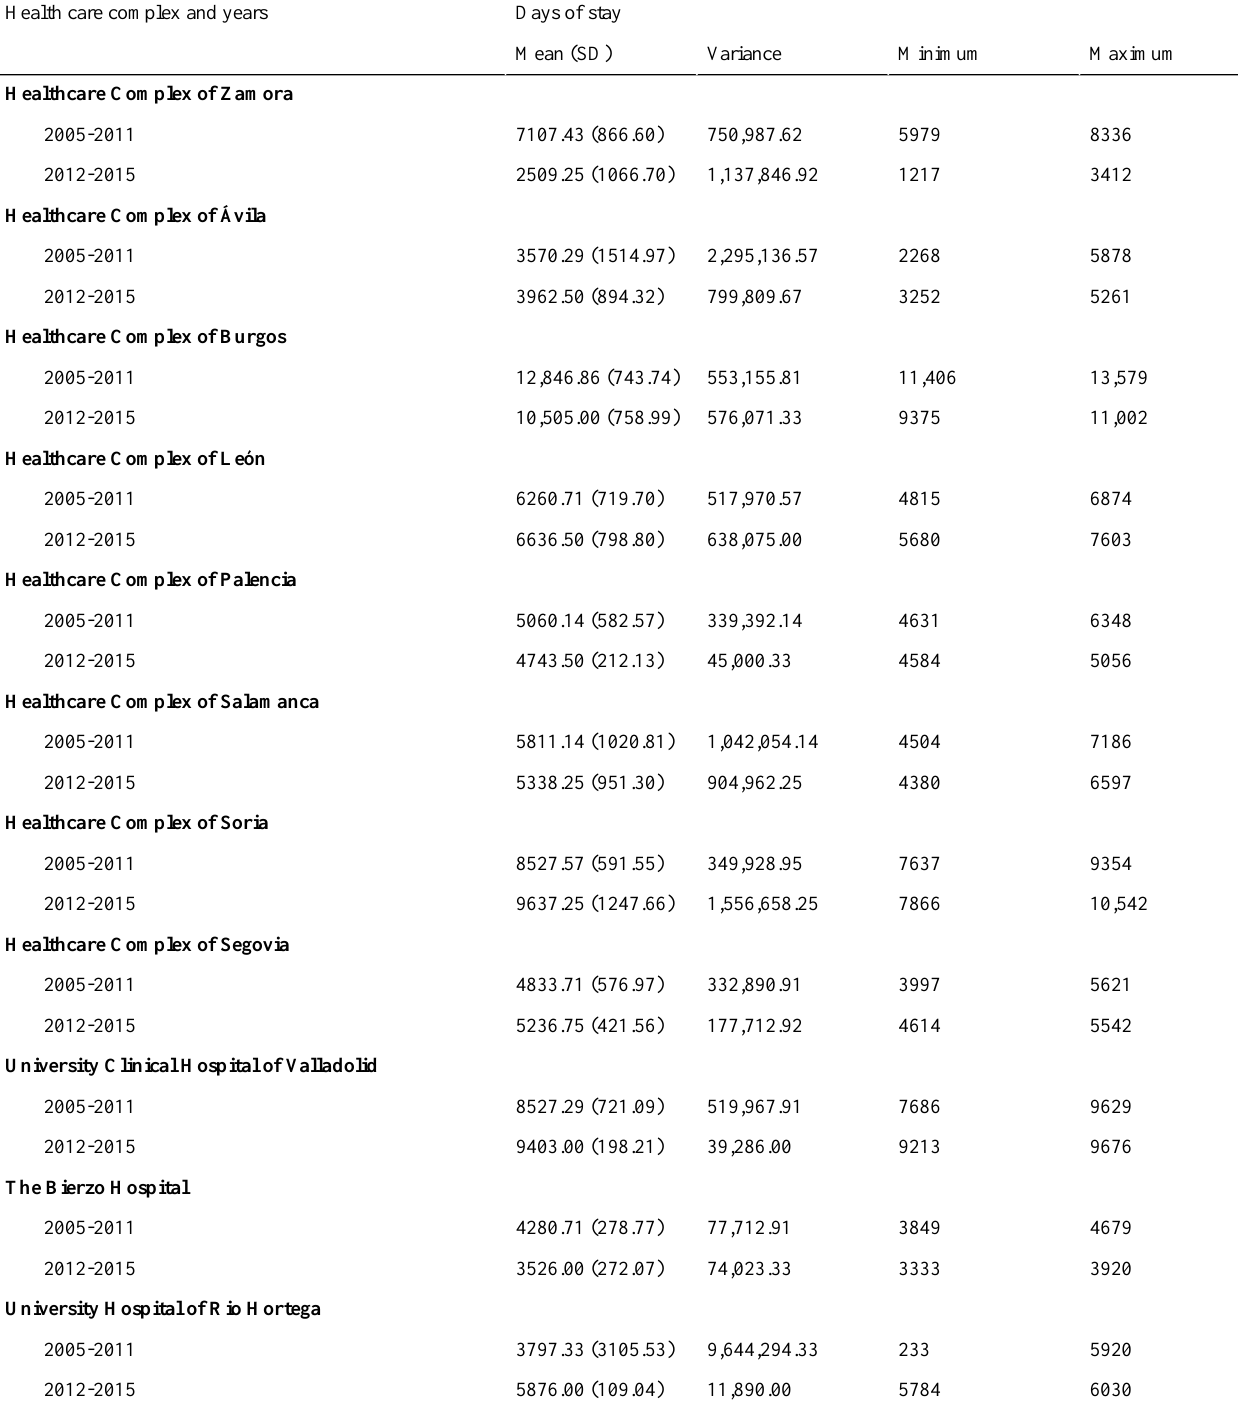
Table 3. Descriptive statistics of total days of stay per hospital over 11 years.